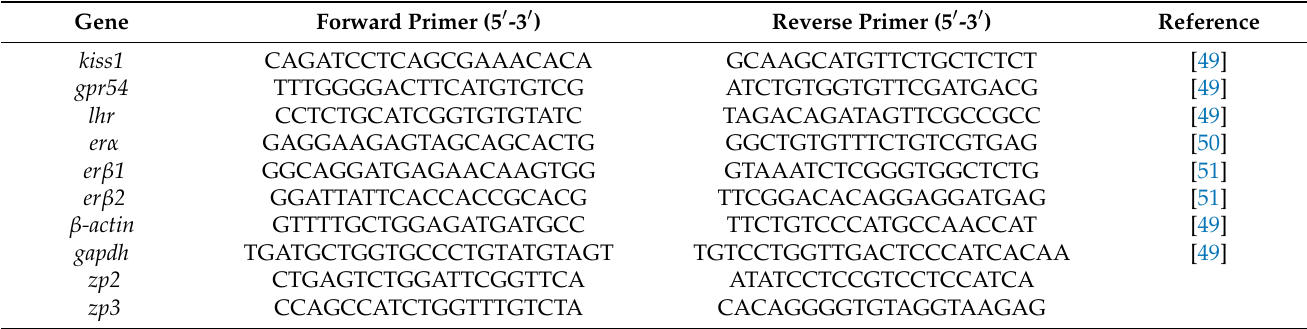
Table 1. Sequences of primers used for real-time quantitative PCR analysis. Gene